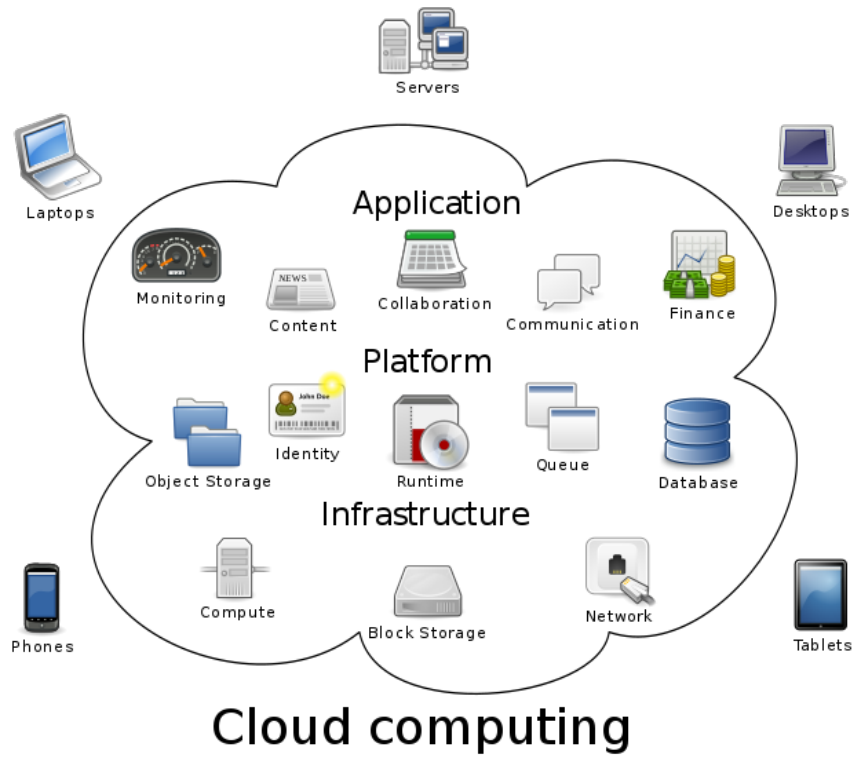
Figure 1. Cloud computing architecture.